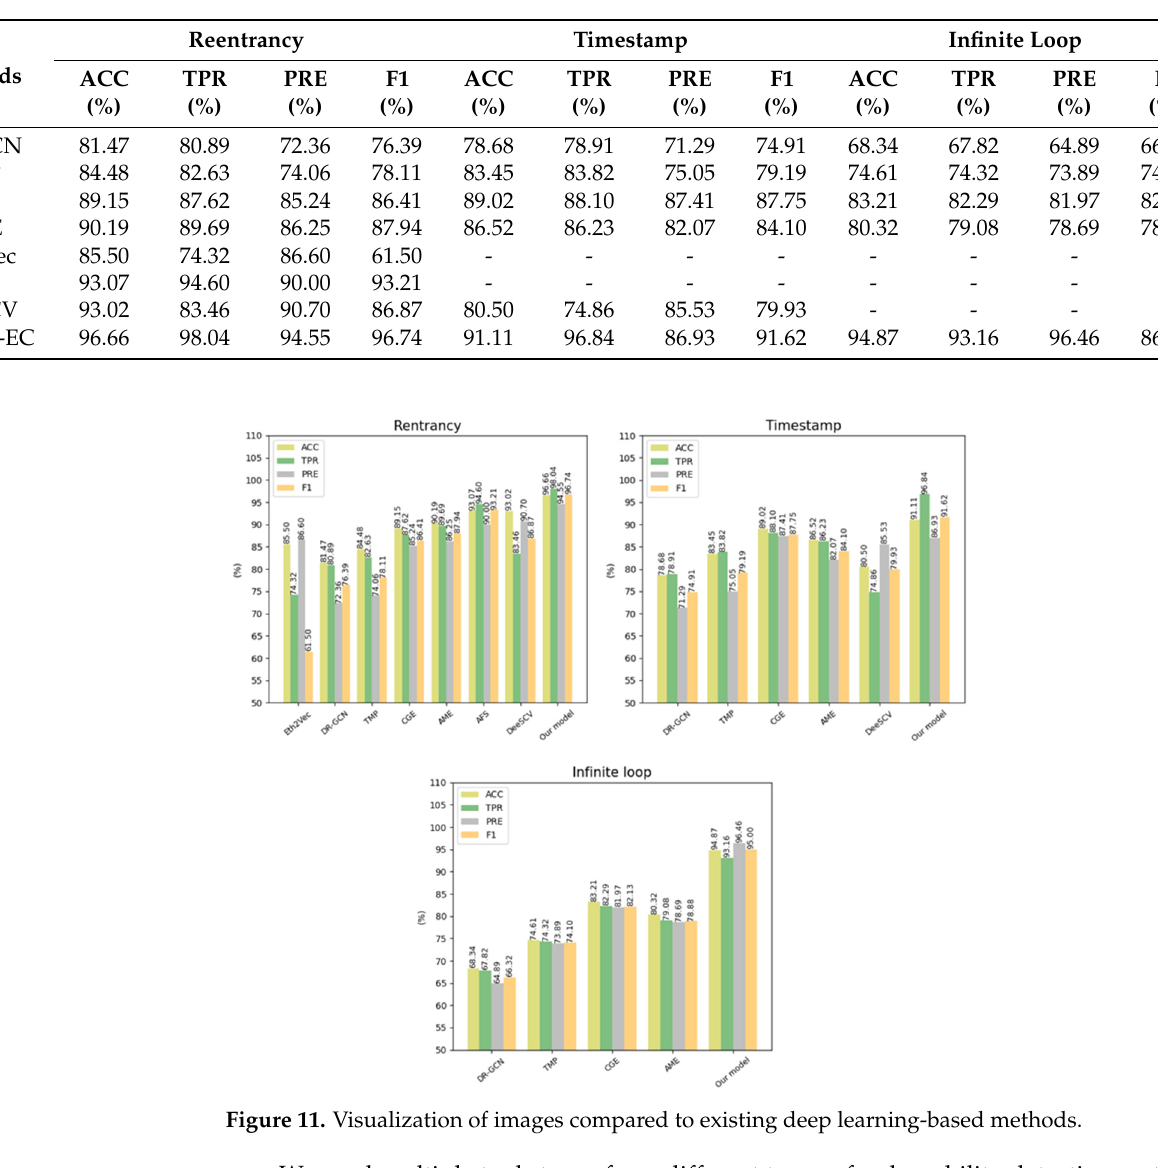
Table 8. Comparison results with existing advanced deep learning-based methods.